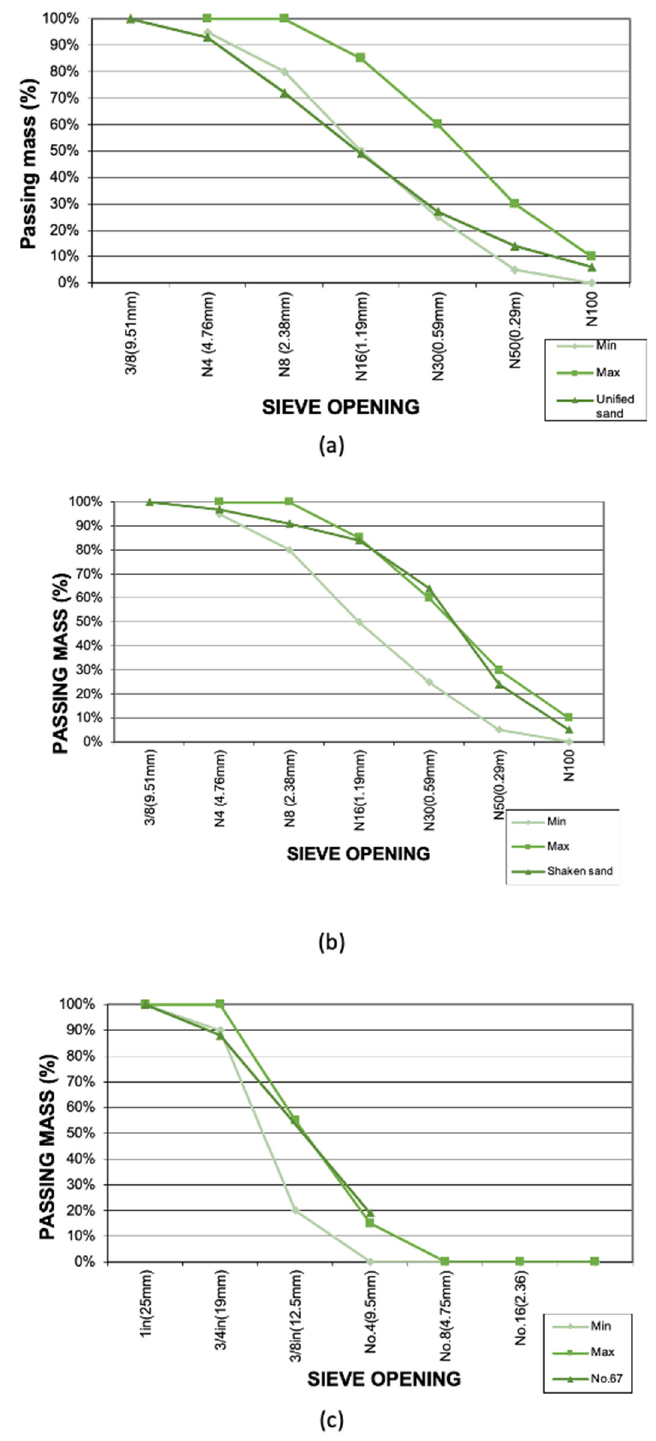
Figure 2. The granulometric curve of: ( a ) river sand; ( b ) crushed sand; ( c ) aggregate No.67.